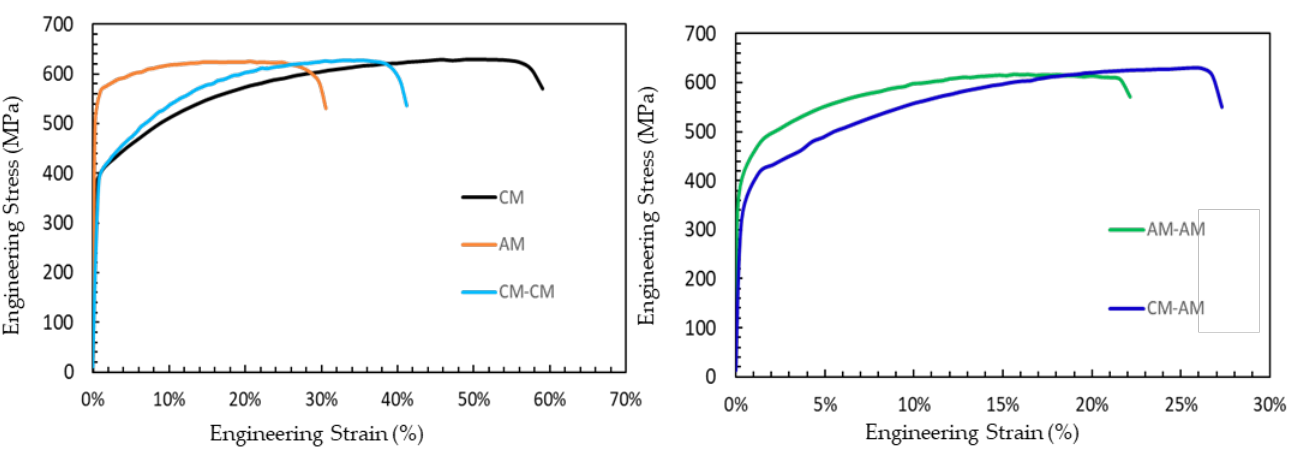
Figure 14. Stress–strain tensile curves of reference and welded samples.